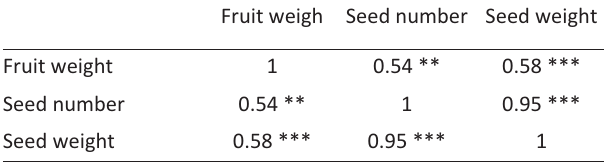
Table 3 ­ Correlation coefficient between fruit weight with seed number and weight in Actinidia deliciosa ‘Hayward’ Fruit weigh Seed number Seed weight Fruit